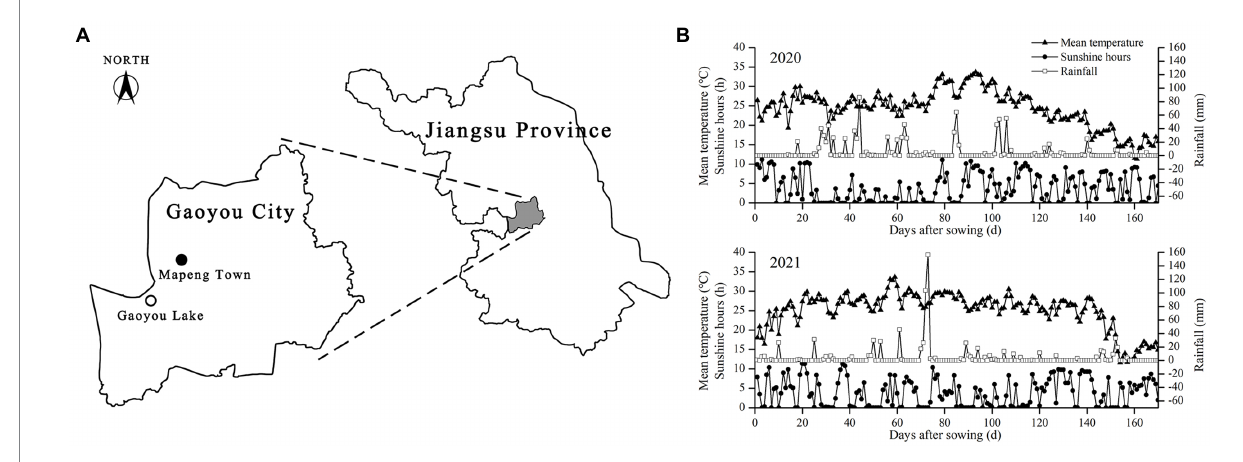
FIGURE 1 The location of the experimental site (A) and meteorological conditions during the whole growth period of rice (B) .